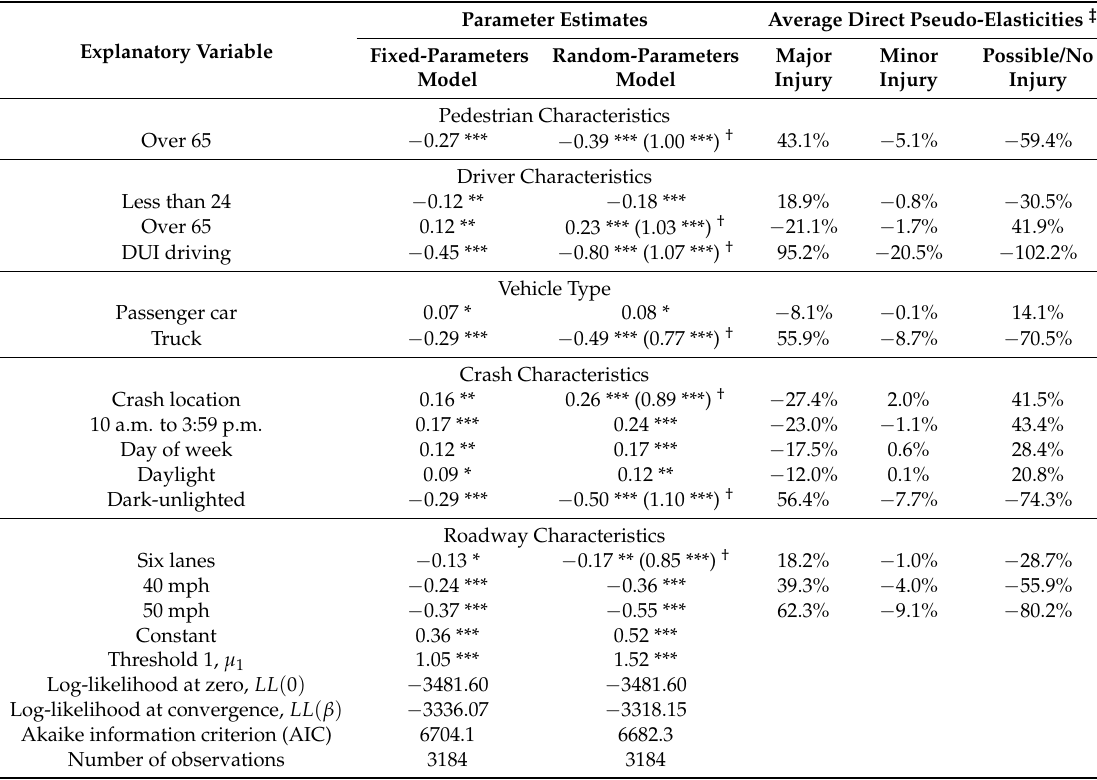
Table 2. Parameter estimates and